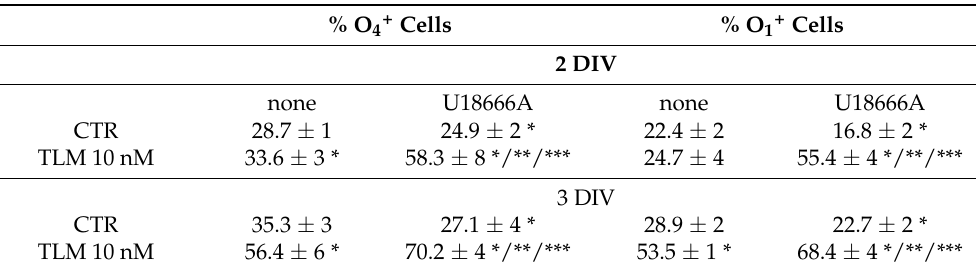
Table 1. TLM rescues OP from maturational arrest induced by U18666A. The percentage of positive cells for O 4 and O 1 compared to the total cell number was evaluated after 24 h (2DIV) or 48 h (3DIV) of treatment in the presence of TLM and/or U18666A. The total cell numbers were counted using the vital nuclear dye Hoechst 33258. Data are Means + SEM of 5–10 independent experiments and evaluate 10–20 coverslips (* p < 0.02 vs. CTR ** p < 0.05 vs. U18666A; *** p < 0.0001 vs. TLM, one-way ANOVA, unpaired two-tailed Student t